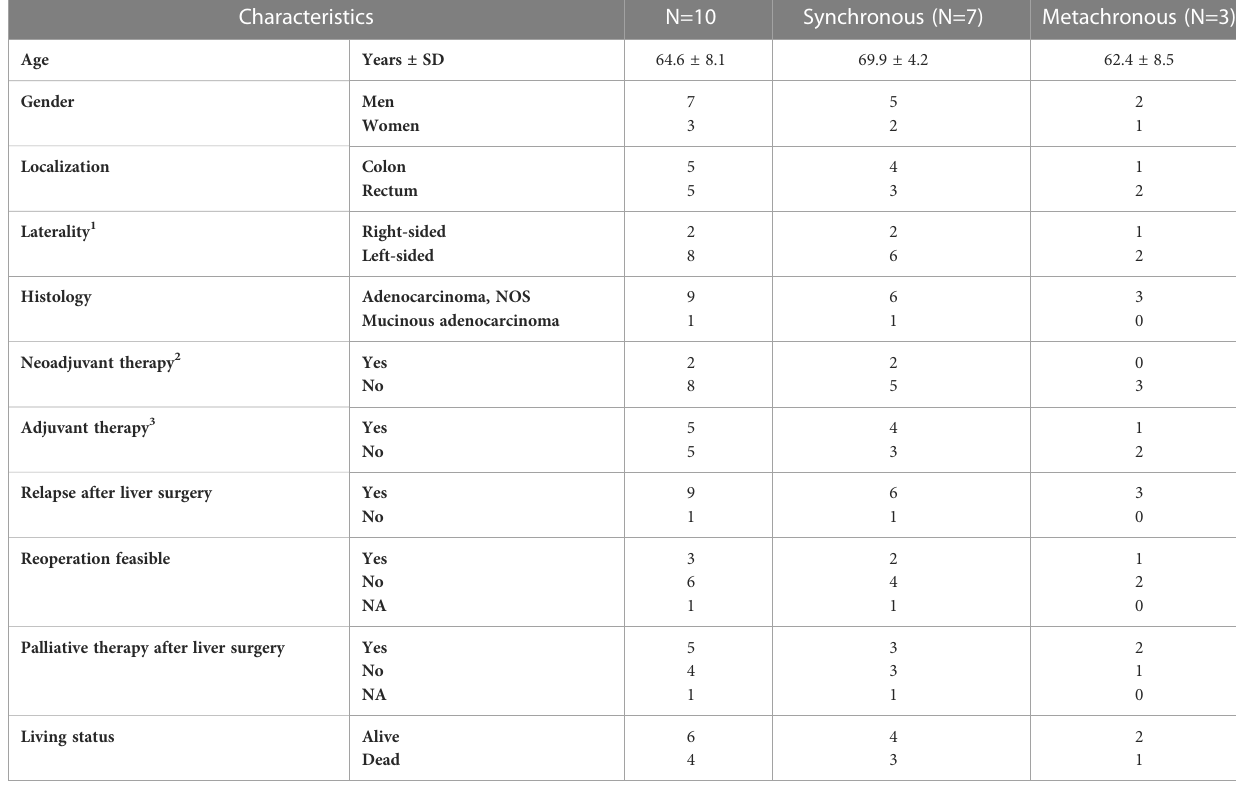
TABLE 1 Patients´